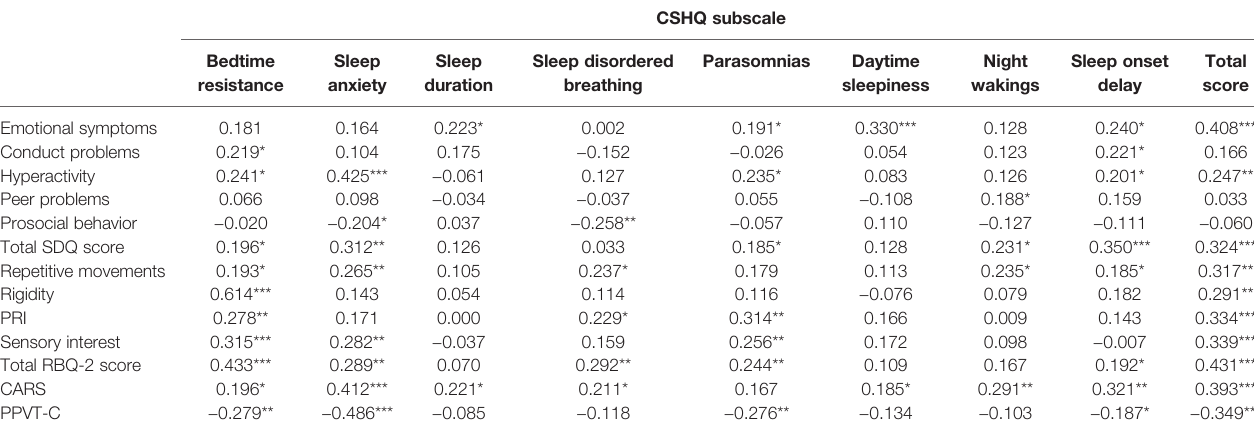
CSHQ subscale Sleep Sleep Sleep disordered Parasomnias Daytime anxiety duration breathing